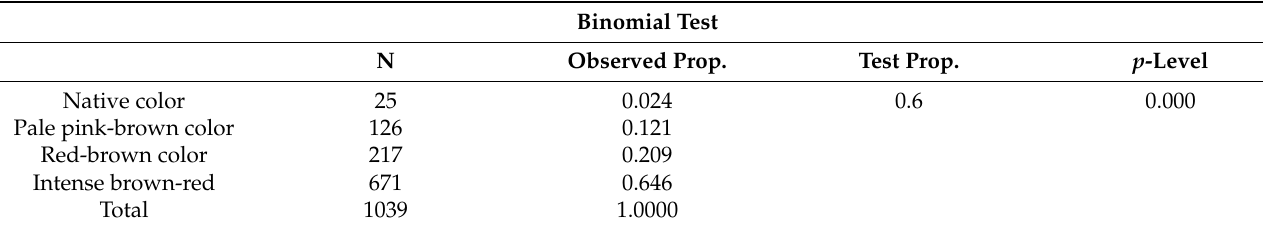
Table 6. Binomial test results for Hypothesis H3.